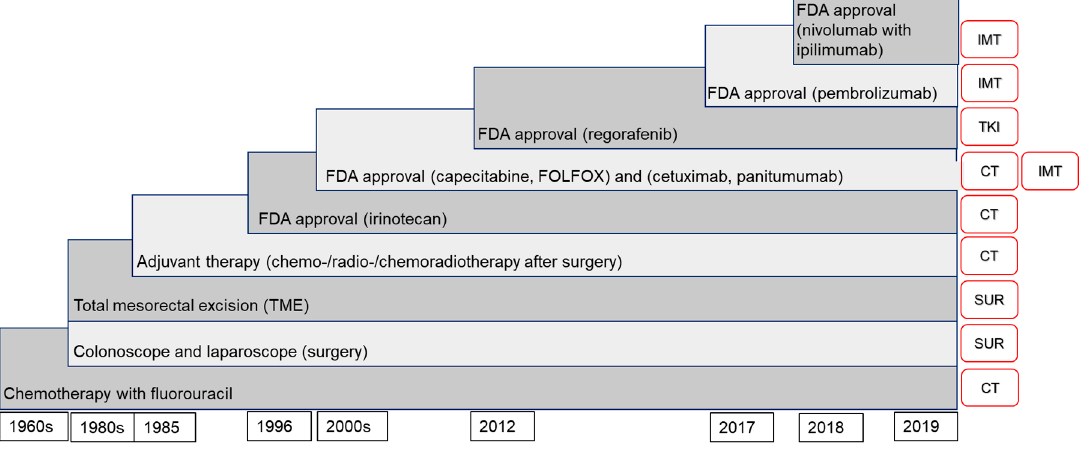
Figure 1. Simplified timeline of colorectal cancer (CRC) treatment options reviewed. The timeline is not constructed according to scale. The red boxes on the right represent the type of treatment, where CT = chemotherapy, SUR = surgery, IMT = immunotherapy, TKI = tyrosine kinase inhibitor.